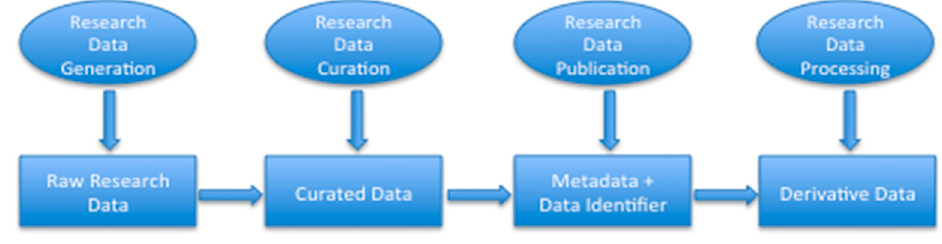
Figure 1. Research Data Lifecycle.